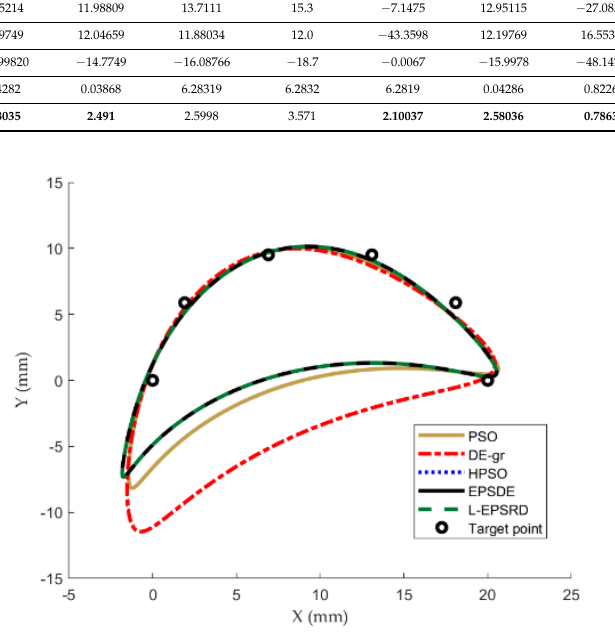
Figure 14. Trajectories of the coupler point of Case 3.